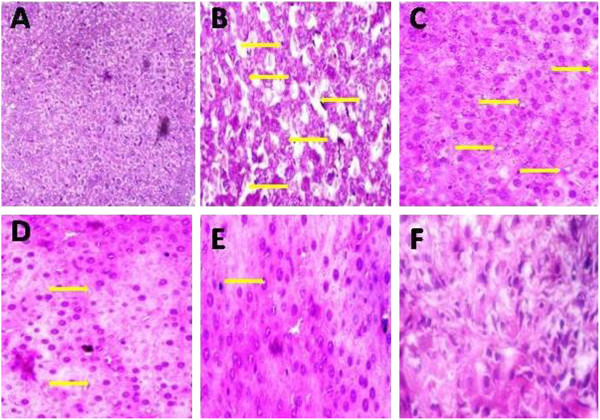
Effect of umbelliferone β-D-galactopyranoside (UFG) on liver in different groups of rat: (A) Normal control: Normal control group Shown normal histopathology (B) Diabetic control: In histopathology of diabetic control group rat shown overblown of micro droplet of fat (yellow arrow indicate) (C) UFG I (10 mg/kg): Histopathology of UFG dose (10 mg/kg) shown deposition of some micro droplet of fat (yellow arrow).(D) UFG II (20 mg/kg): In the histopathology of dose UFG (20 mg/kg) showed few micro droplet deposition of fat (yellow arrow). (E) UFG III (40 mg/kg): Histopathology of UFG (40 mg/kg) drug not showing any fat deposition and other changes. (F) Glibenclamide (10 mg/kg): Histopathology of glibenclamide treated drug group shown similar to the normal control groups. The samples were obtained from the same liver anatomical regions. For each group, 6 rats were examined and 80 pictures were taken. The above picture for each group was chosen randomly from the 80 pictures in this group. Original magnification, 40 × .